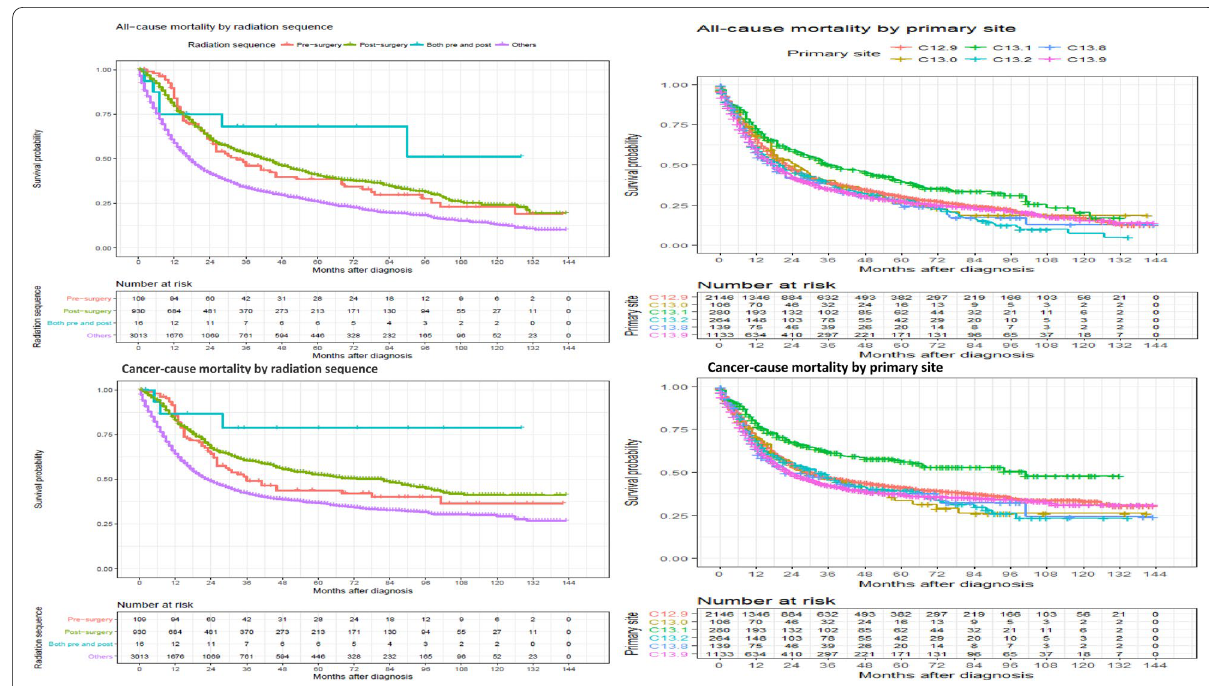
Fig. 2 All-cause and cancer-specific radiation sequence with surgery and primary site. Note: C12.9, pyriform sinus; C13.0, post-cricoid region; C13.1, aryepiglottic fold; C13.2, posterior wall of the hypopharynx; C13.8, overlapping lesion; C13.9, not otherwise